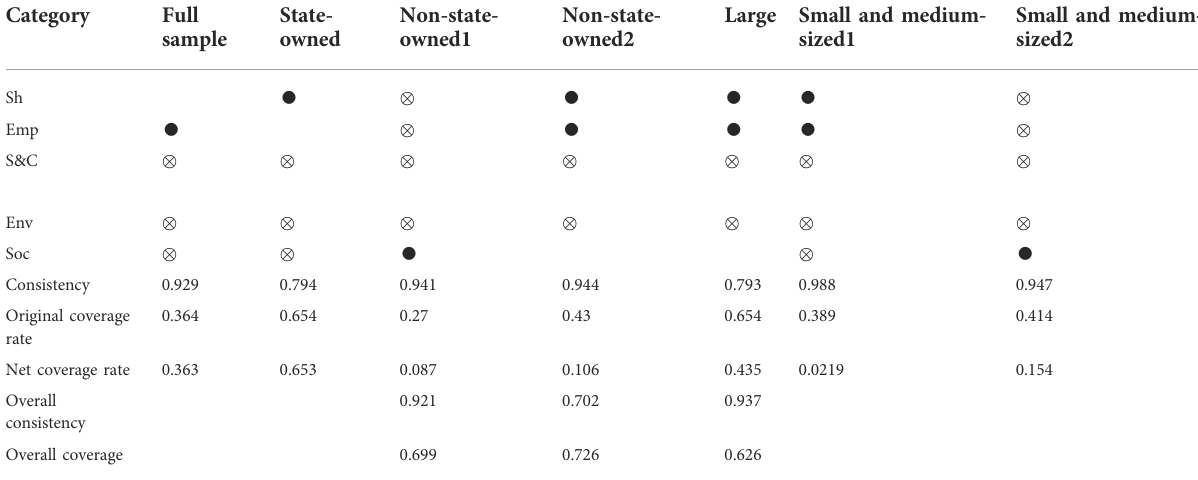
TABLE 5 Path Con fi gurations of non-high green value performance under different conditions.